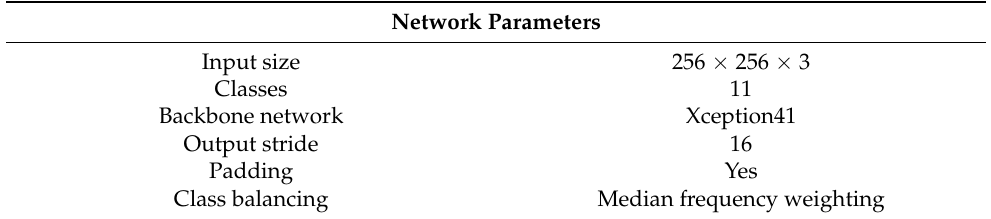
Table 6. Network parameters for DeepLabV3+ on UOPNOA.